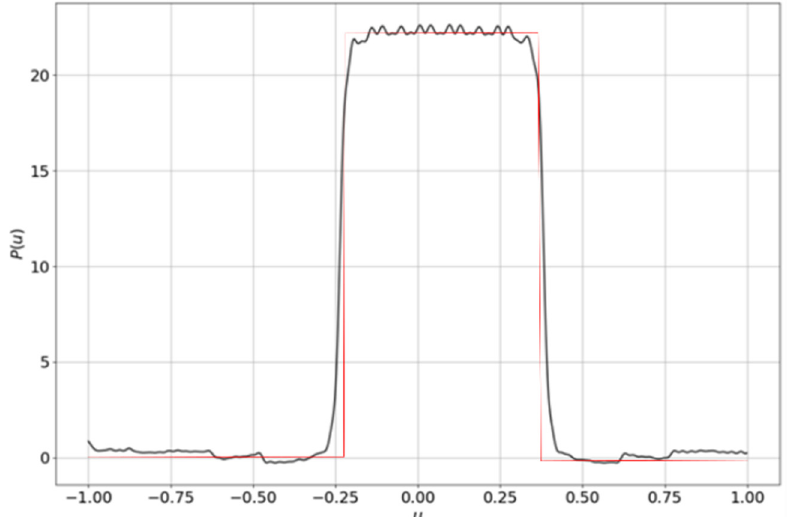
Figure 3. Statistical distribution P ( u ) obtained as the inverse Fourier transform of the amplitudes of the diffraction peaks (Equation (3)). The characteristic oscillations for numerical calculations are observed. The non-symmetricity of P ( u ) is due to the chosen definition of a variable u . The width of the distribution is τ (the distribution is not normalized). Calculations performed for 500 atoms in the Fibonacci chain, diffraction amplitudes obtained with Equation (2). The red line represents the ideal shape of the P ( u ) distribution known theoretically for the Fibonacci chain (see, e.g., [17]). The shift from u = 0 results from the choice of the range selection of variable u in the calculation based on Equation (3).